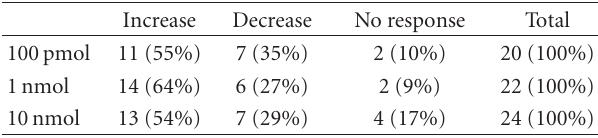
Table 1: Response of GP neurons to di ff erent concentrations of